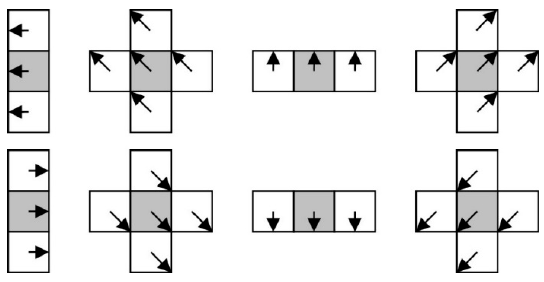
Figure 4. The eight cases for parallel adjacent cells.